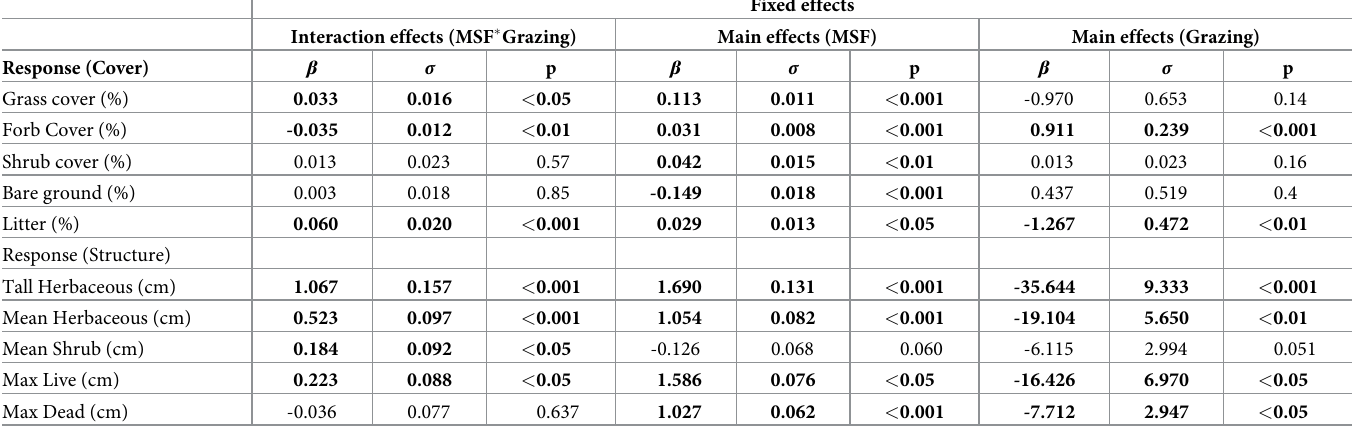
Regression coefficients, standard errors, and significance levels for fixed effects of the fire-grazing interaction and the main effects of months since fire (MSF) and grazing. Bold text indicates significance at the α < 0.05